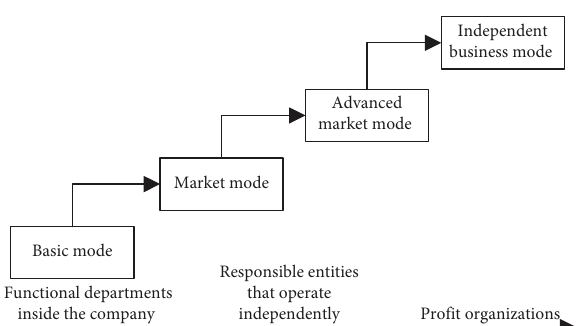
Figure 1: Operation modes of FSS.